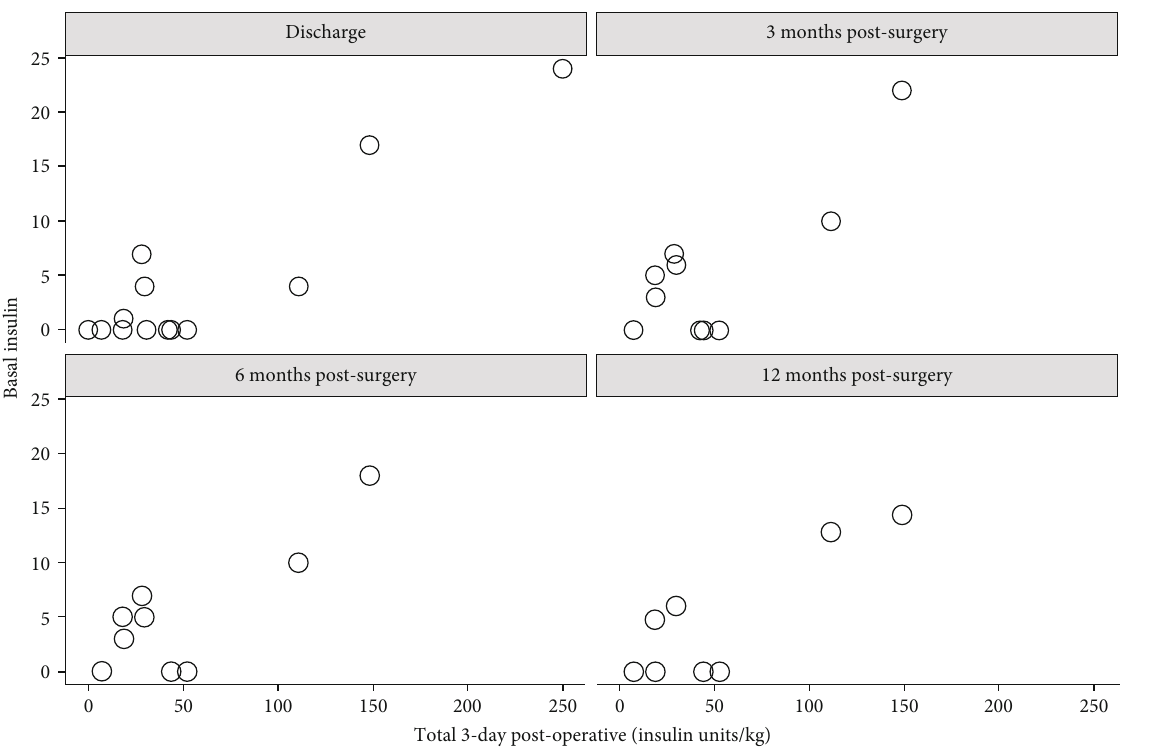
Figure 4: Absolute postoperative basal insulin requirement per kilogram (insulin units/kg) in the immediate postoperative period of 72 hours showed a positive correlation with basal insulin requirement (insulin units) at 3 months, 6 months, and 12 months postoperatively. These correlations were consistently strong and signi fi cant through 12 months